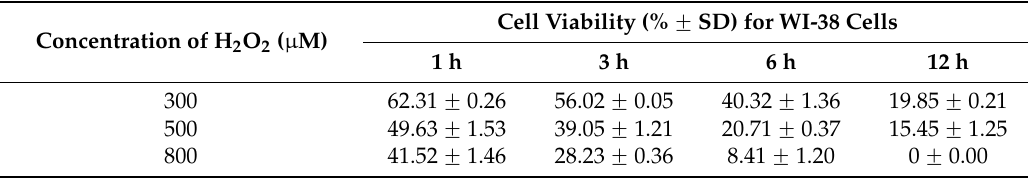
Table A2. Effect of concentration and exposure time of H 2 O 2 on the percentage cell viability of human lung fibroblasts (WI-38